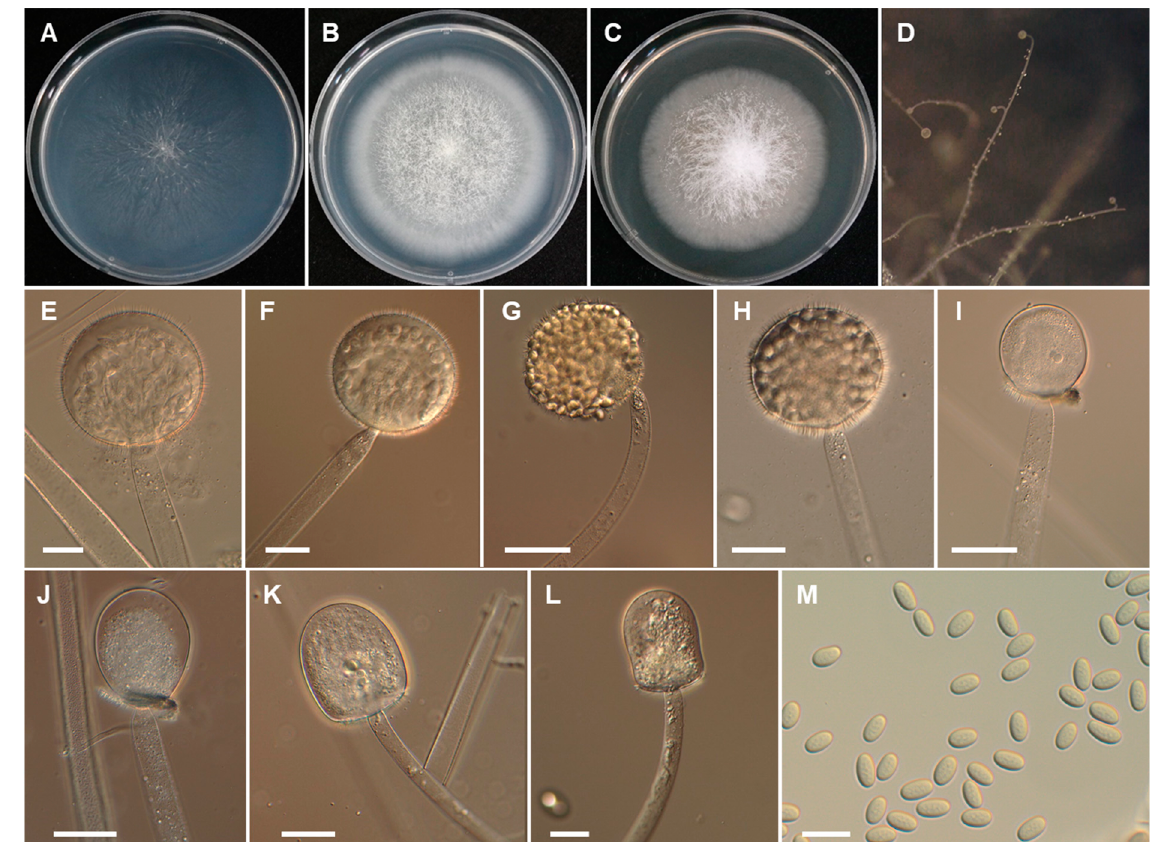
Figure 7. Morphology of Backusella oblongispora . A , Colony on SMA. B , Colony on PDA. C , Colony on MEA. D , Sporangium on circinate branches. E–H , Young and mature sporangia. I–L , Columellae of various shapes. M , Sporangiospores. Scale bars: E–L = 50 μ m, M = 20 μ m.